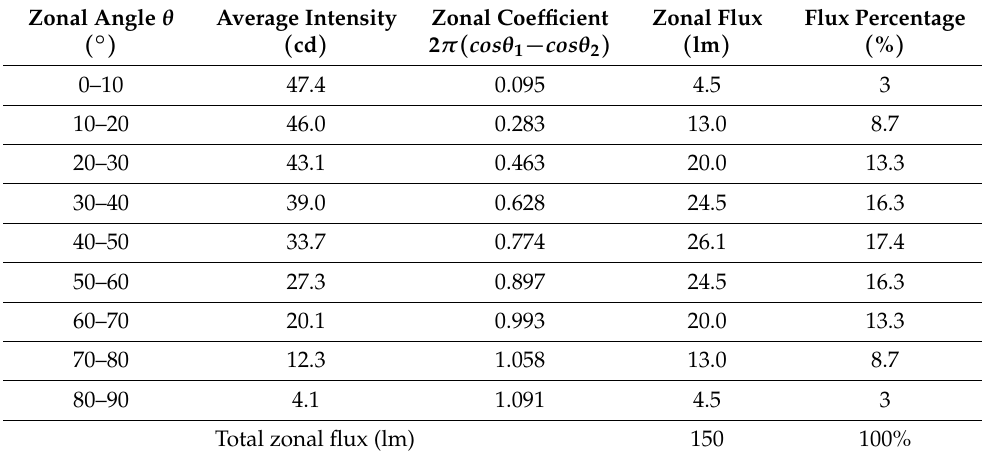
Figure 9. Rebel ES LED: ( a ) entity diagram; ( b ) mechanical dimensions [37]. Table 4. Zonal flux analysis of Rebel ES LED (100